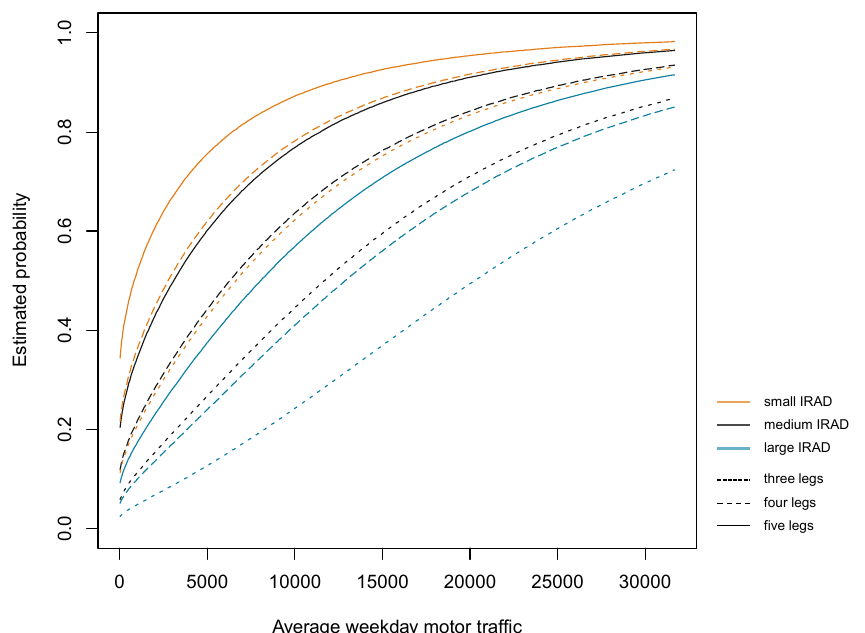
Figure 2. Accident occurrence probability vs. average weekday motorized traffic: Estimated probabilities of having at least one accident recorded at a roundabout with small (2.6, midpoint first quartile) [orange], median (6.15) [black] and large (10.7, midpoint last quartile) [blue] radius of the central island against average weekday motorized traffic for roundabouts located in town with three [dotted line style], four [dashed] and five [continuous line style] legs.